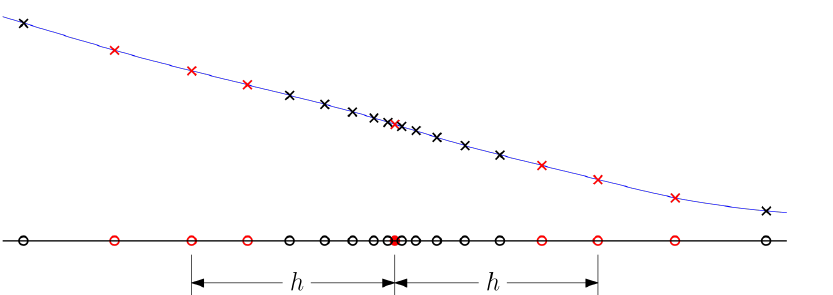
Figure 2. Example of how sample points are selected for polynomial fits. The black line is the ordinate for the design variable, and the blue curve is the response curve. The solid red circle represents the central point in the design space. Open circles represent the different samples on the ordinate. Crosses represent the corresponding points on the response curve. Red markers represent the points selected for a 7-point polynomial fit associated with step h